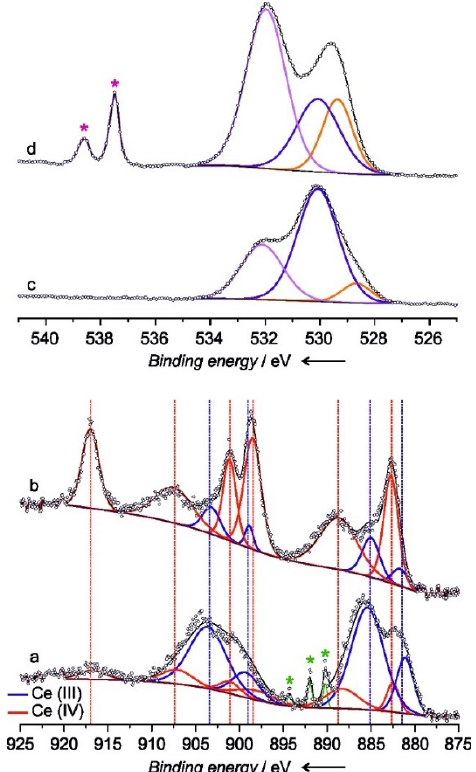
Figure 1. Ce 3d ( a , b ) and O 1s spectra ( c , d ) recorded over Ce 0.8 Zr 0.2 O 2 -soot at 823 K under an argon atmosphere ( a , c ) and by replacing Ar with O 2 ( b , d ). Reprinted with permission from [135], copyright 2016, Wiley Online Library.